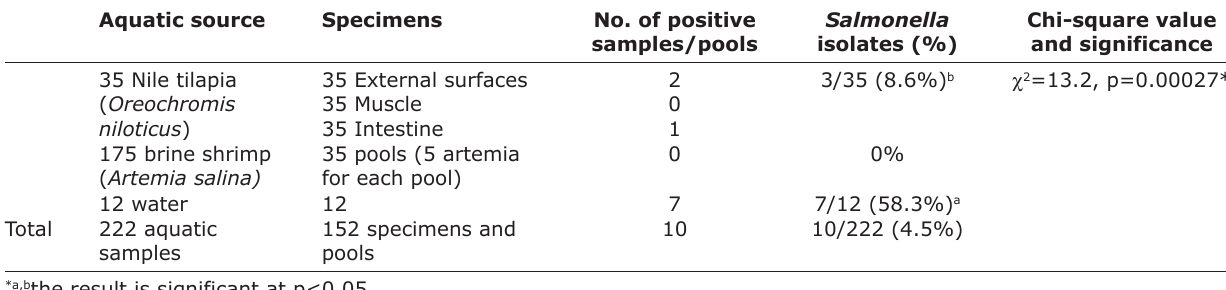
Table-5: Prevalence of Salmonella in fin fish, brine shrimp, and water samples collected from Lake Qarun. Aquatic source